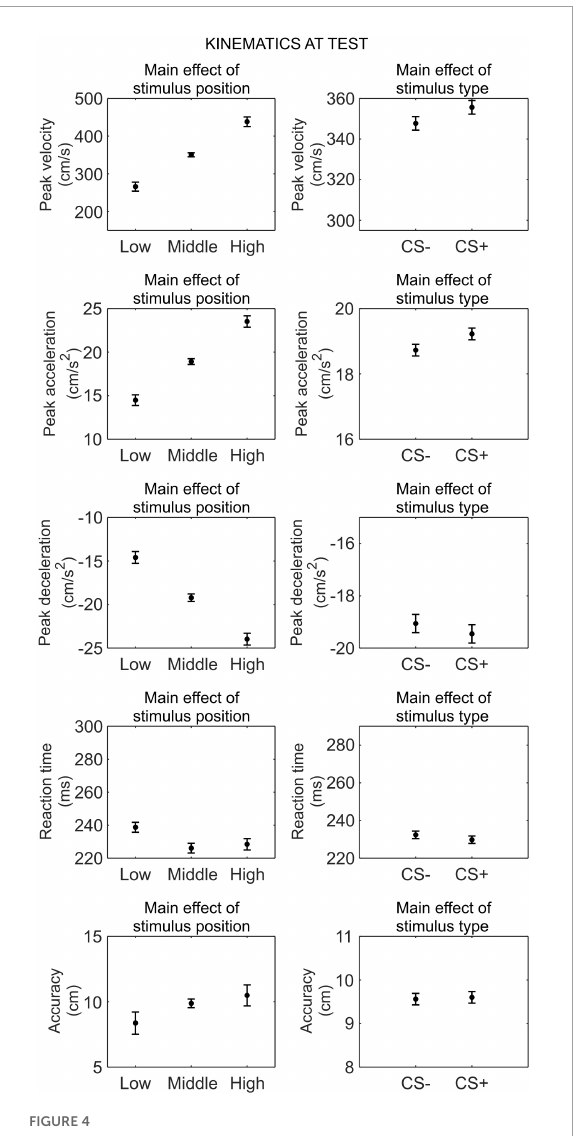
FIGURE4 Kinematics at test. Each plot shows the group mean (black dot) and 95% confidence intervals (vertical bars) of the different kinematic parameters as a function of the stimulus position or the stimulus type. 95% CI were corrected for within-subjects designs (Cousineau,